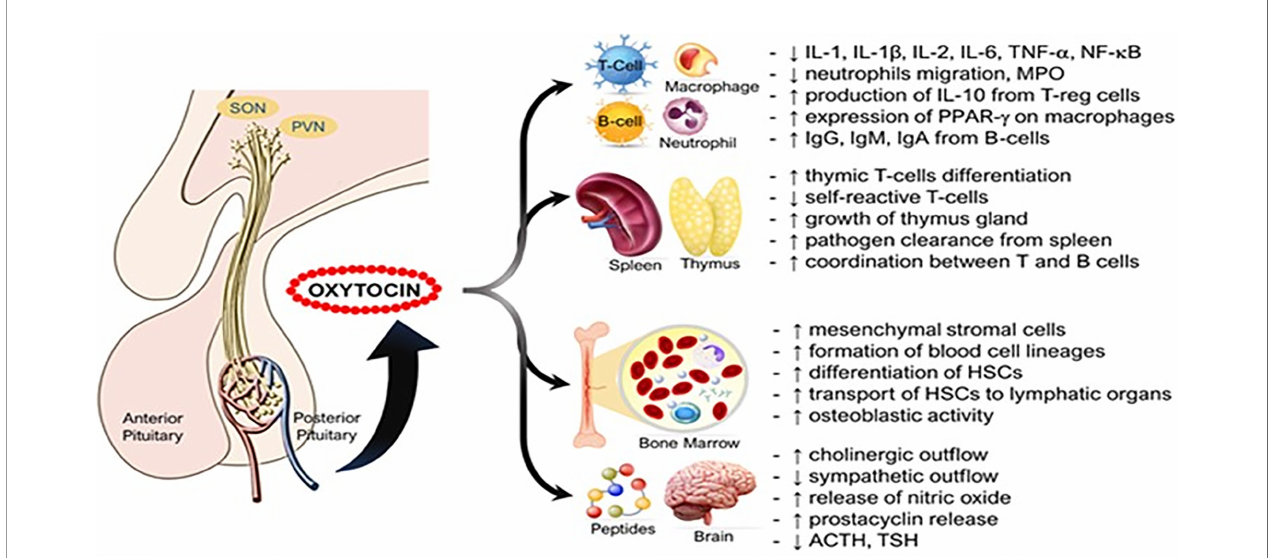
FIGURE 2 | Immune functions of oxytocin. Oxytocin acts peripherally on immune cells, immune organs (thymus, spleen, bone marrow), and centrally on the nervous system to modulate its immunogenic effects. ACTH, adrenocorticotropic hormone; HSCs, hematopoietic stem cells; Ig, Immunoglobulin; IL, interleukin; MPO, myeloperoxidase; PPAR- g , peroxisome proliferator-activated receptor gamma; PVN, paraventricular nucleus; SON, supraoptic nucleus; TSH, thyroid-stimulating hormone. Other annotations are the same as Figure 1 [Figure originates and adapted from articles (57 – 59)]. Up arrow ( ↑ ) symbol indicates increase, whereas down ( ↓ ) arrow symbol indicates decrease in the effect